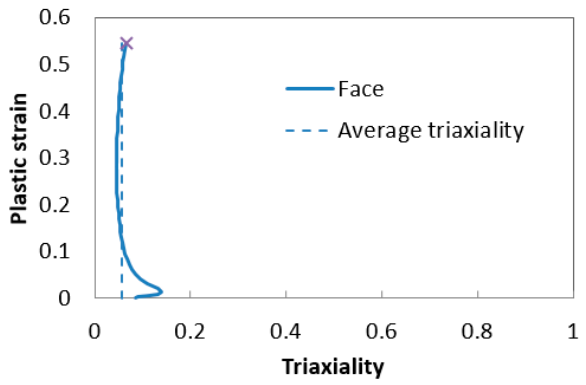
Figure 26. Triaxiality paths for the plane strain test at two points.